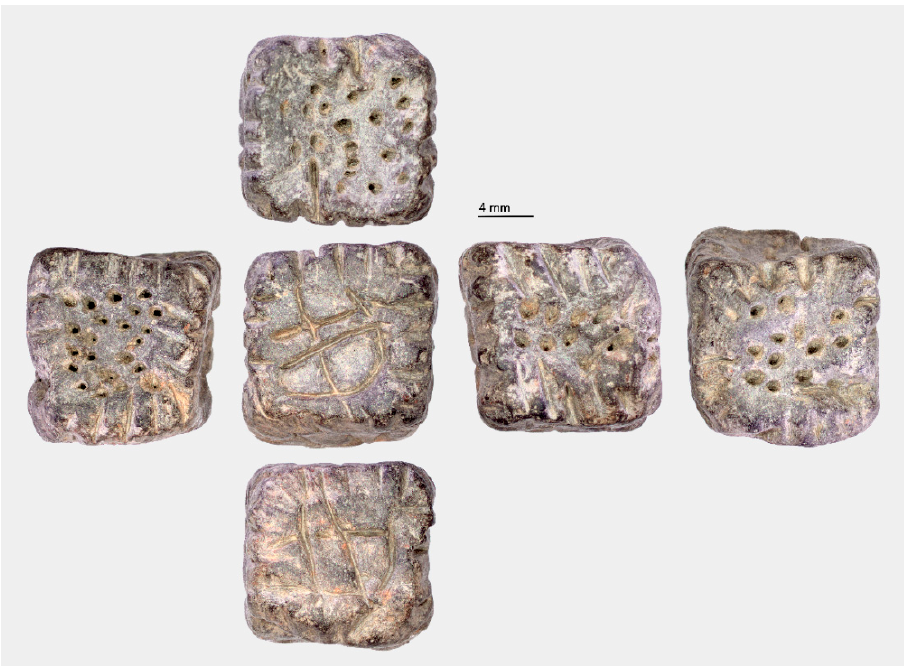
Figure 2. The dice CDA95-C35-F2 from Castello di Annone with signs, dots and two Etruscan numbers in letters [12]. Scale bar: 4 mm.